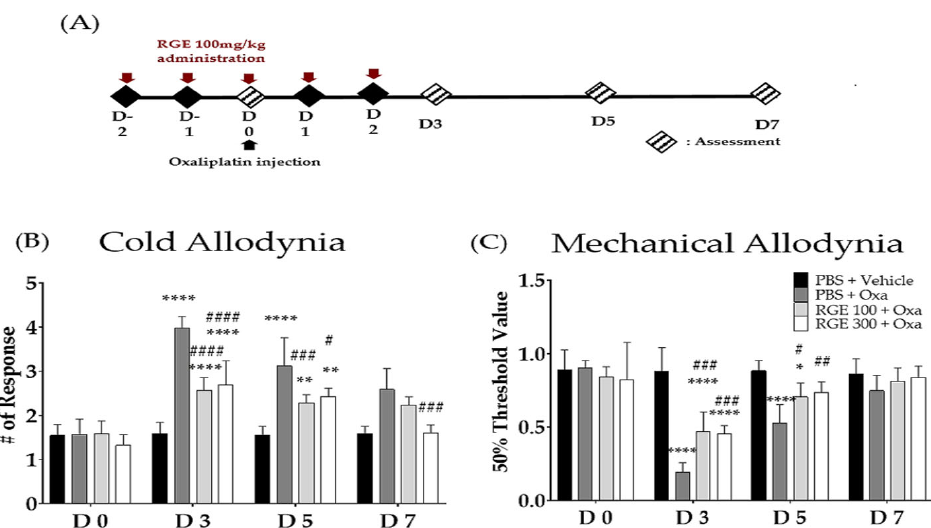
Figure 2. Effect of red ginseng extract (RGE) 100, 300 mg/kg on the cold and mechanical forms of allodynia induced by oxaliplatin injection in mice. The experimental schedule ( A ) and the effects of RGE against oxaliplatin-induced cold ( B ) and mechanical ( C ) forms of allodynia in mice. Behavioral tests to measure allodynia were performed before (D0) and after three times a day (D3, D5, D7). PBS and vehicle (5% glucose) were used as controls as they are solvents of RGE and oxaliplatin, respectively. N = 6 for each group; **** p , #### p < 0.0001, ### p < 0.001, ** p, ## p < 0.005, * p, # p < 0.05 vs. vehicle group with a two-way ANOVA followed by Sidak’s post-test for multiple comparisons. The ANOVA test found interaction F -values of 12.42 and 8.966 for the cold and mechanical forms of allodynia,